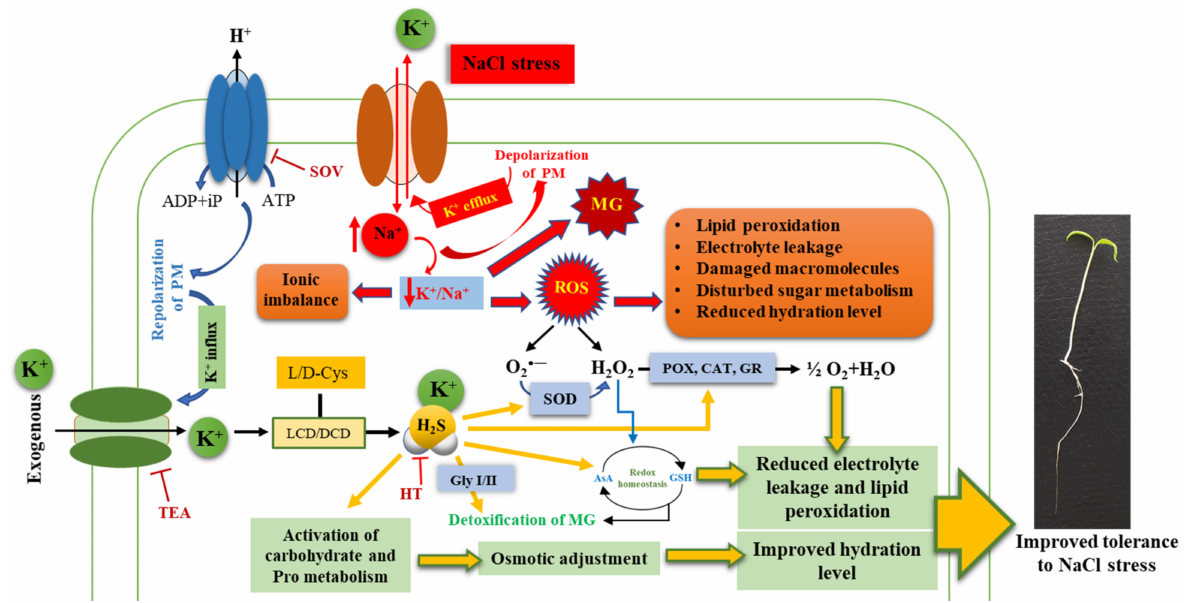
Figure 11. Illustration showing the role of potassium (K + ) and hydrogen sulfide (H 2 S) in the regulation of carbohydrate metabolism and antioxidative defense system under NaCl stress. CAT: Catalase, DCD: D-cysteine desulfhydrase, Gly I/II: Clyoxalase I/II, GR: Glutathione reductase, HT: Hypotaurine, LCD: L-cysteine desulfhydrase, L/D-Cys: L/D-cysteine, MG: Methylglyoxal content, ROS: Reactive oxygen species, SOV: Sodium orthovanadate (H + -ATPase inhibitor), SOD: Superoxide dismutase, POX: Peroxidase, TEA: Tetraethylammonium chloride (K + channel